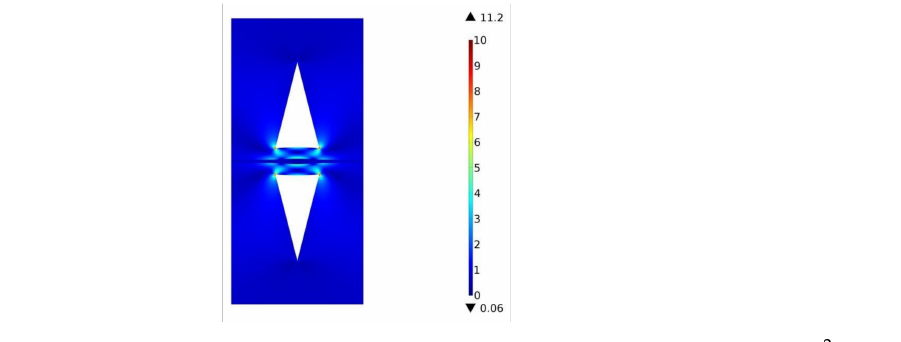
Figure 12. von Mises stress variations (MPa) in the PEM-FC through the process of assembly at the 1 mm 2 cross-section area with scale increased 50 times.